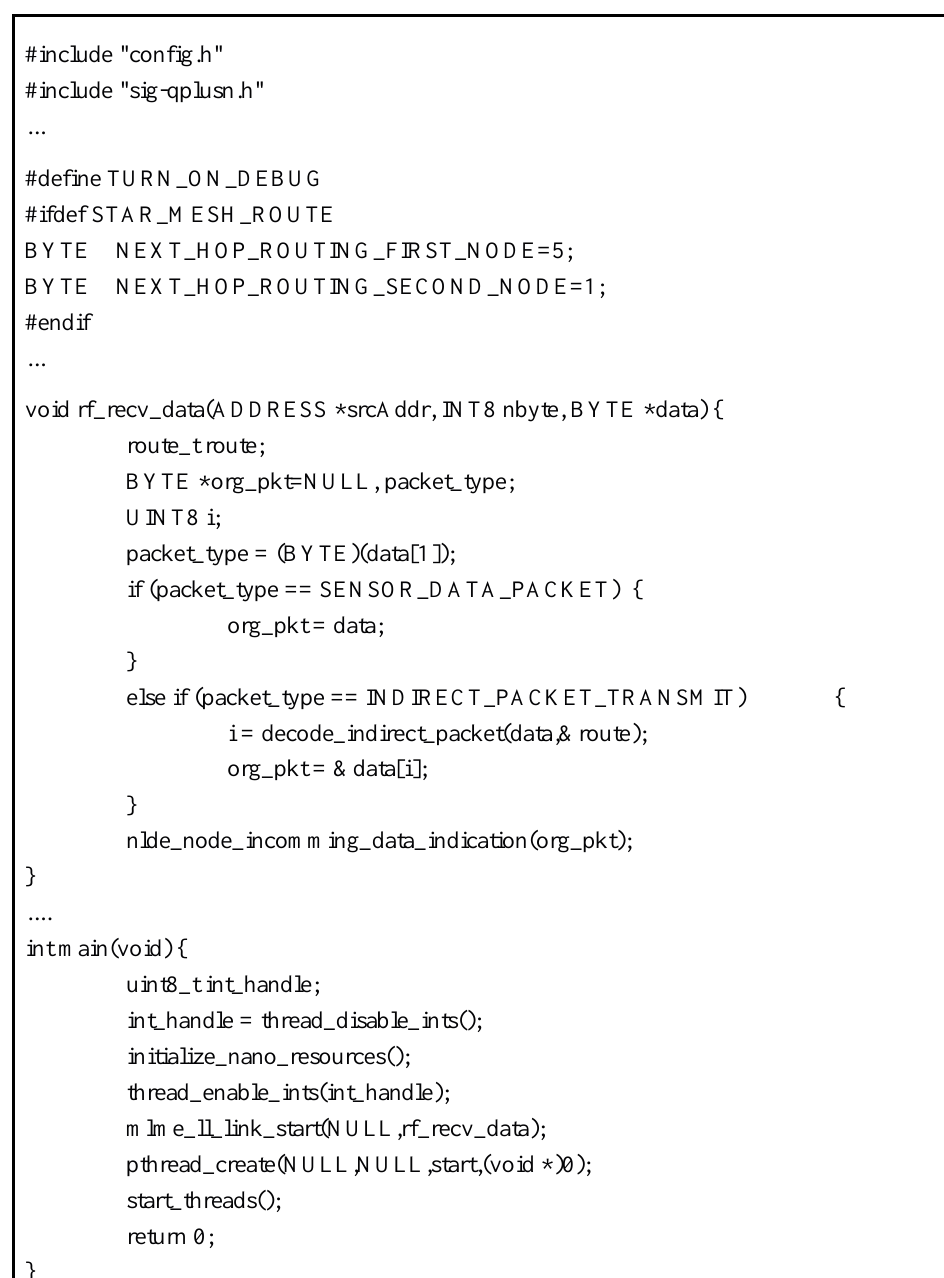
Figure 10. Generated source code for